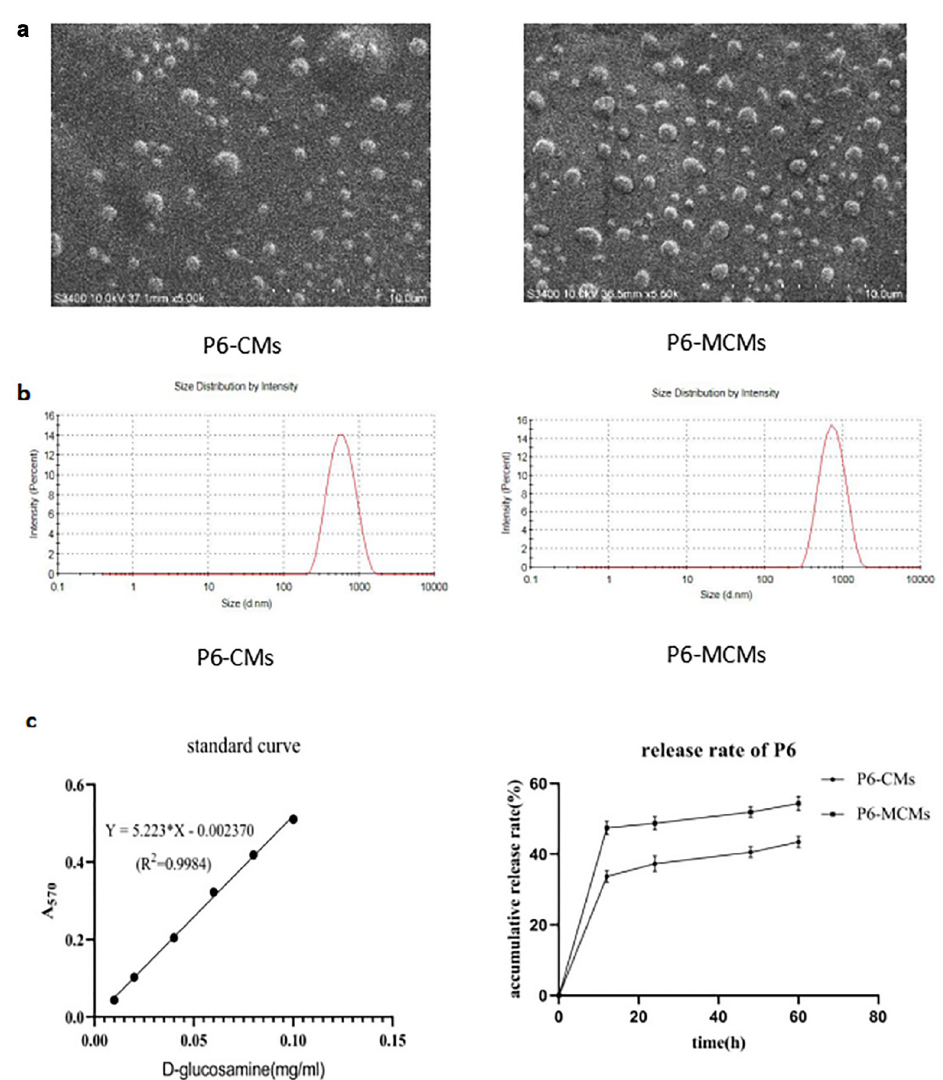
Fig 3. Characteristics and evaluation of P6-CMs and P6-MCMs. A SEM images of P6-CMs and P6-MCMs (5000x); the scale bar represents 10 μ m. B Particle size distribution by intensity (percent) of P6-CMs and P6-MCMs. C Standard curve for D-glucosamine hydrochloride (100% free amino, 0.1 mg ml -1 ) at different volumes. The slope was 5.2233, R 2 = 0.9984. D Continuous release profiles of P6-CMs and P6-MCMs at different times in vitro. Mean ± SD, n = 3.